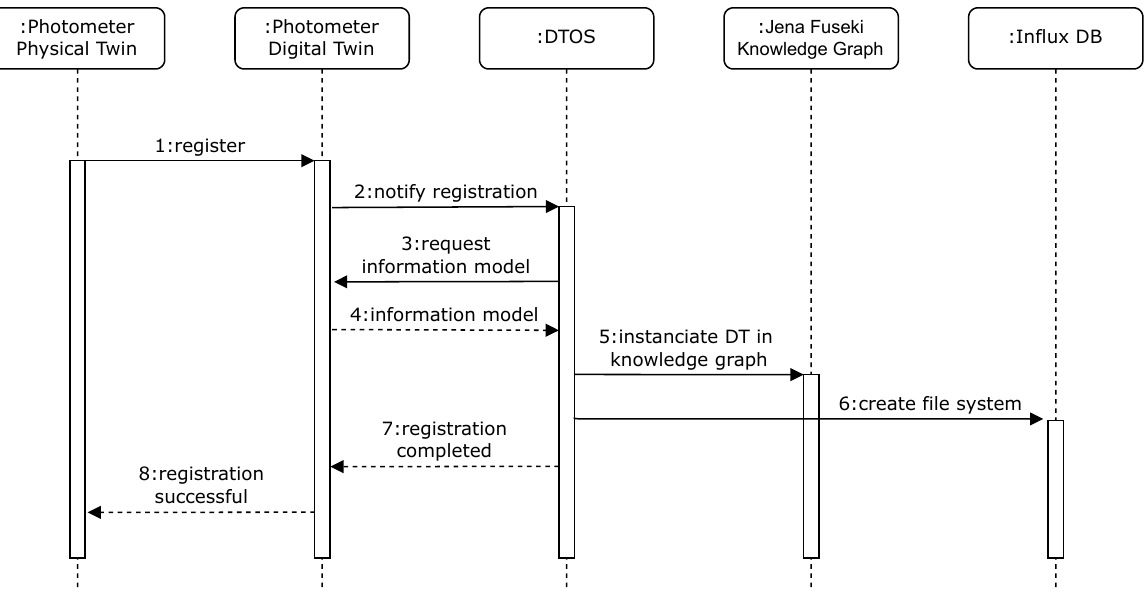
Figure 6. Registration of a Digital Twin within the RDM Core